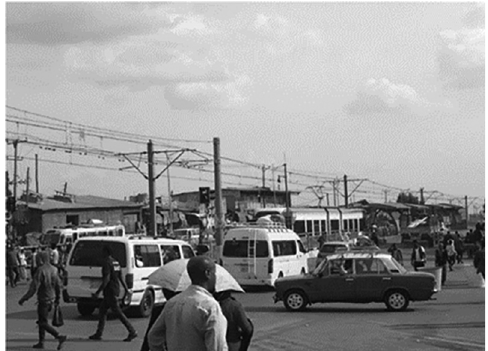
Figure 3. Uncoordinated movement of vehicle and people at Sebategna RLC, photo taken